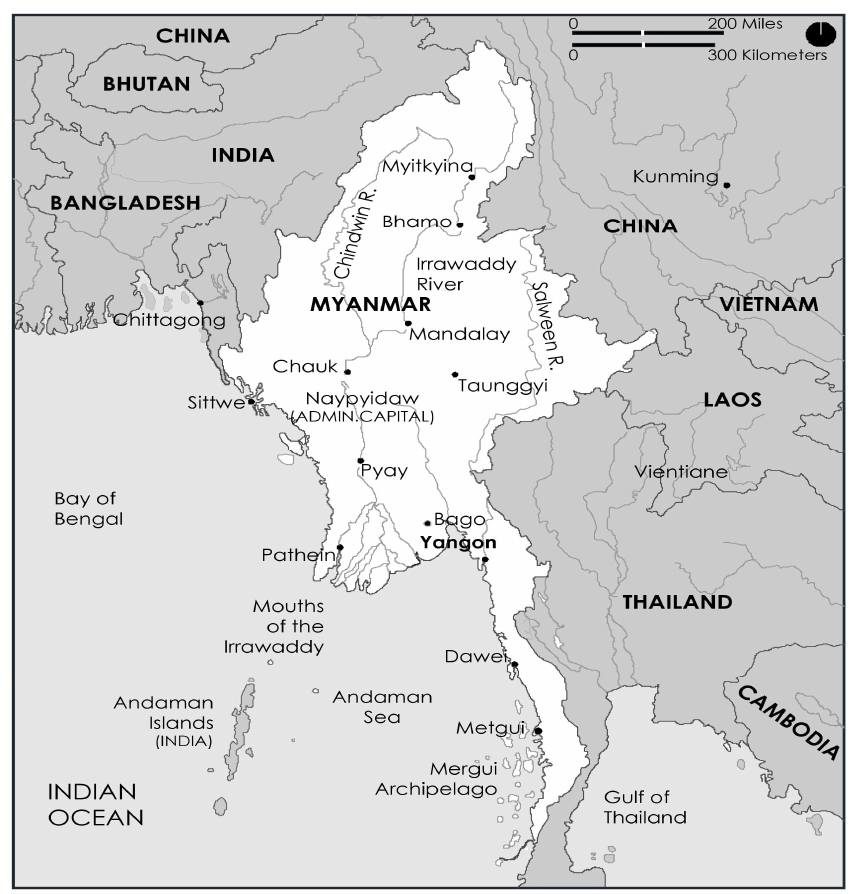
Figure 1. Map showing the Myanmar Region.